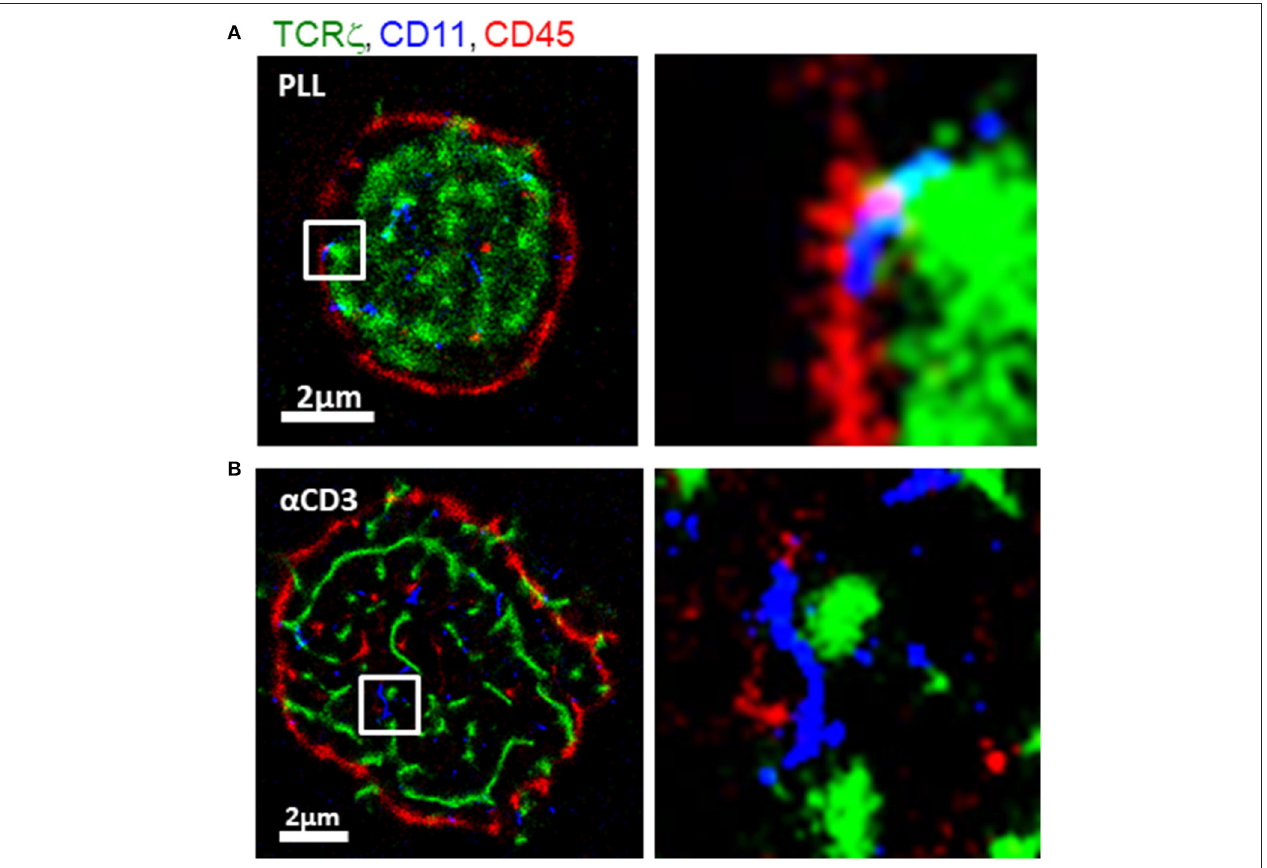
FIGURE 2 | Intricate molecular patterning at the immune synapse. Three-color PALM/dSTORM imaging of fixed E6.1 Jurkat cells expressing TCR ζ -Dronpa (green) and stained for CD45 (red) and CD11 (blue). The cells were dropped on coverslips coated with either (A) poly-L-lysine (PLL; top raw) or (B) α CD3 (bottom raw). Cells were let spread on the coverslip for 1.5min before fixation. Shown are representative cells ( N = 40 cells on PLL and 31 cells on α CD3). Bars − 2 µ m.